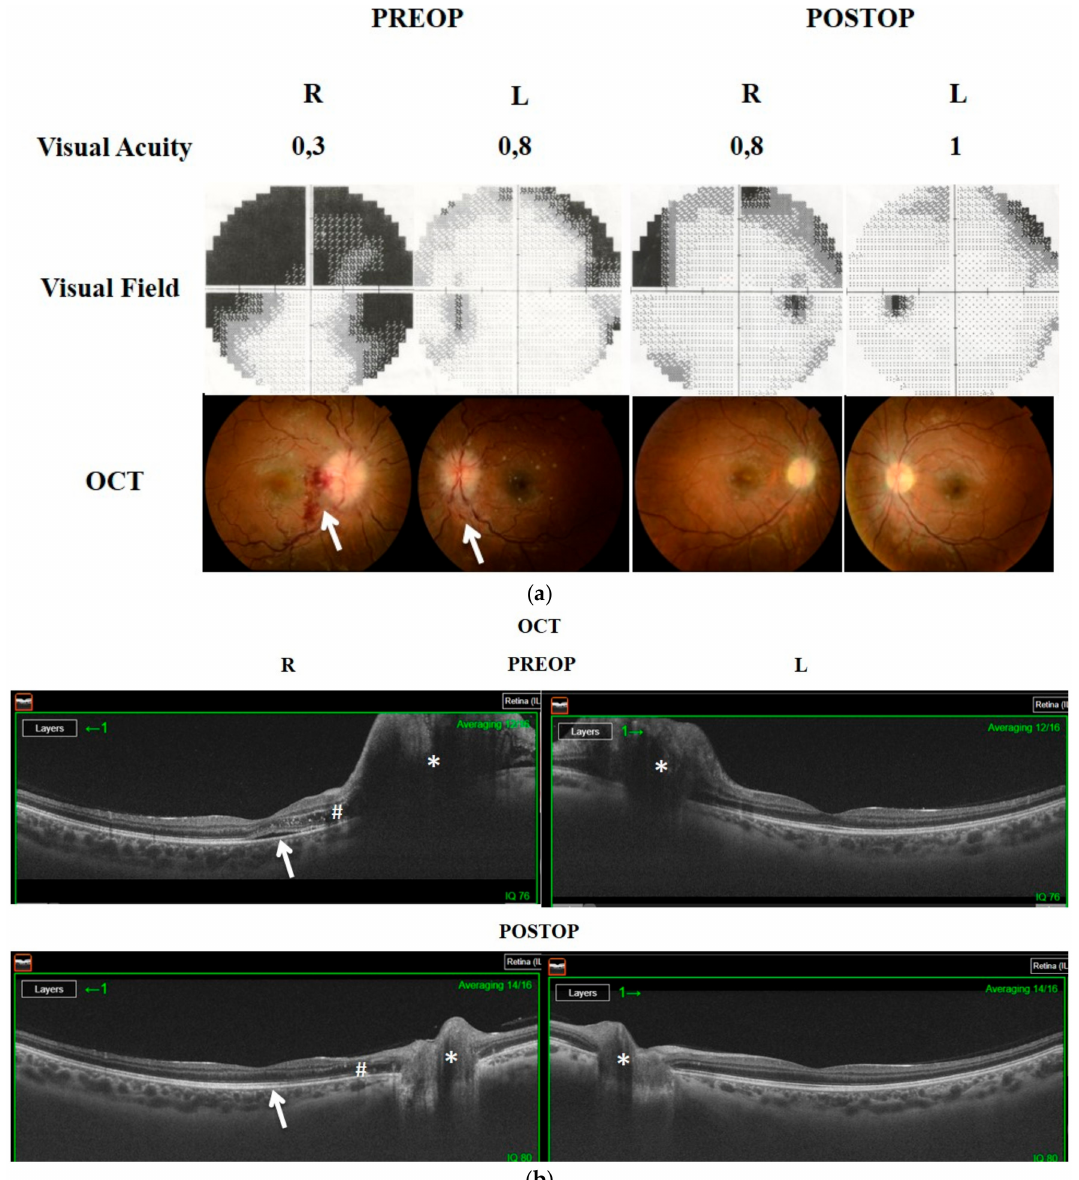
Figure 6. ( a ). The 28-year-old female (Case 9) presented with headaches and progressive visual loss, particularly in the right eye. Visual acuity was 0.3/0.8, and the visual field revealed a large defect in the right eye. She had a severe degree of optic disc edema, markedly vascular engorgement, and retinal folds with bleeding in the temporal peripapillary region. White arrows show the hemorrhages in the right and left eye. Two months following EOND, visual acuity, the visual field, and OCT findings improved. ( b ). Preoperative OCT also demonstrated bilateral optic disc swelling (*) with retinal edema (#) and subretinal fluid under fovea (white arrow) in the right eye. Postoperatively, the bilateral optic disc swelling noticeably improved (*), retinal edema (#), and subretinal fluid (arrow) regressed in the right